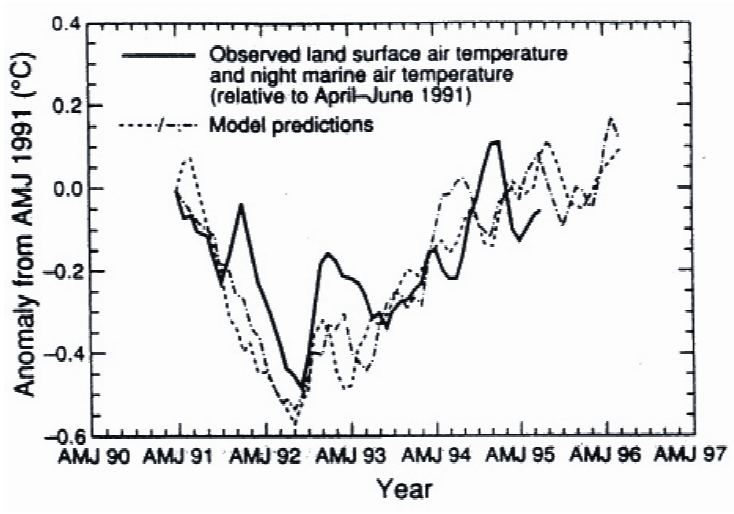
FIGURE 16. Predicted and observed changes in global land and ocean surface air temperature after the eruption of Mt. Pinatubo. Lines represent changes of 3-month running mean temperature from April to June 1991 until March to May 1995. The two model lines represent predictions starting from different initial atmospheric